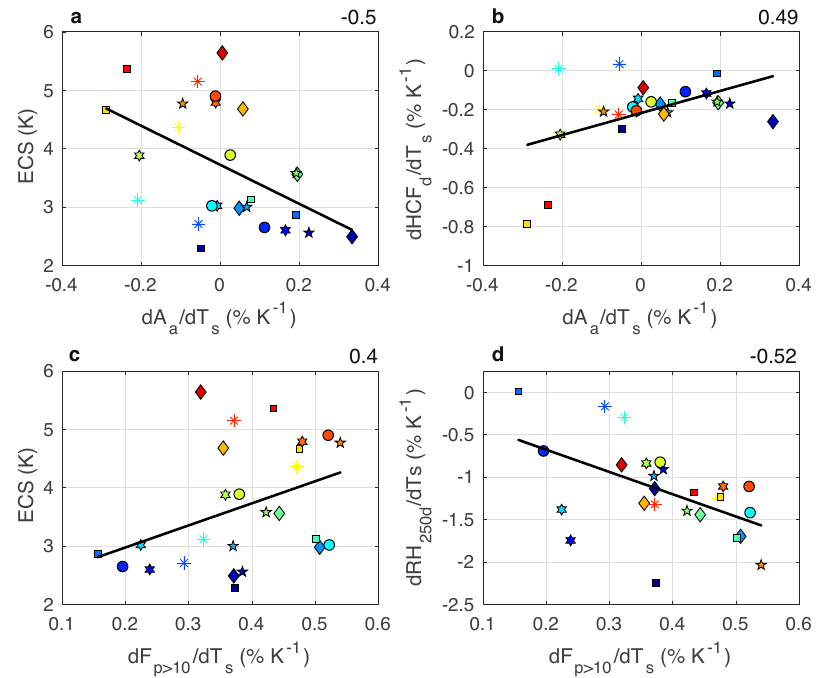
Fig.2|Greaterascentareafractionreductionandincreasesinthefrequencyof heavy precipitation are seen in models with higher climate sensitivity. The relationships between ( a ) the change in ascent area fraction (dA a /dT s ; % K − 1 ) and climatesensitivity(ECS;K),( b )dA a /dT s andthechangeindesentregionhighcloud fraction (dHCF d /dT s ; % K − 1 ), ( c ) the change in the frequency of heavy precipitation (dF p>10 /dT s ; % K − 1 ) and ECS, and ( d ) dF p>10 /dT s and the change in descent region